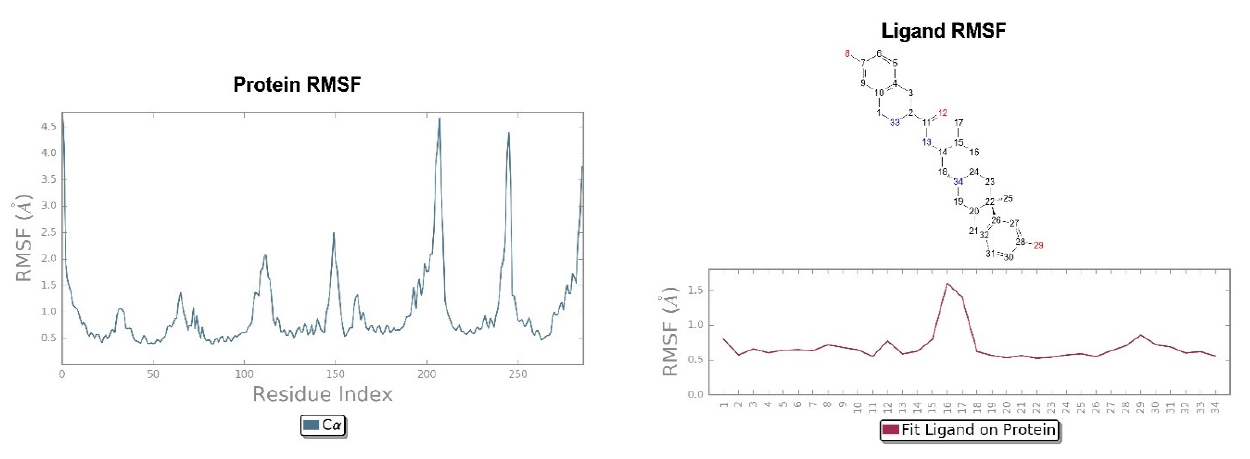
Figure 5. On the left: P-RMSF for KOR; on the right: L-RMSF of JDTic.